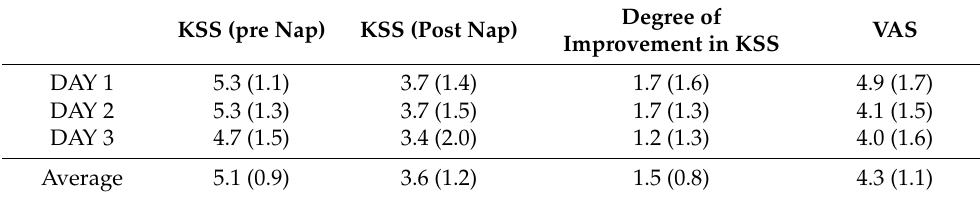
Table 2. Changes in subjective sleepiness before and after